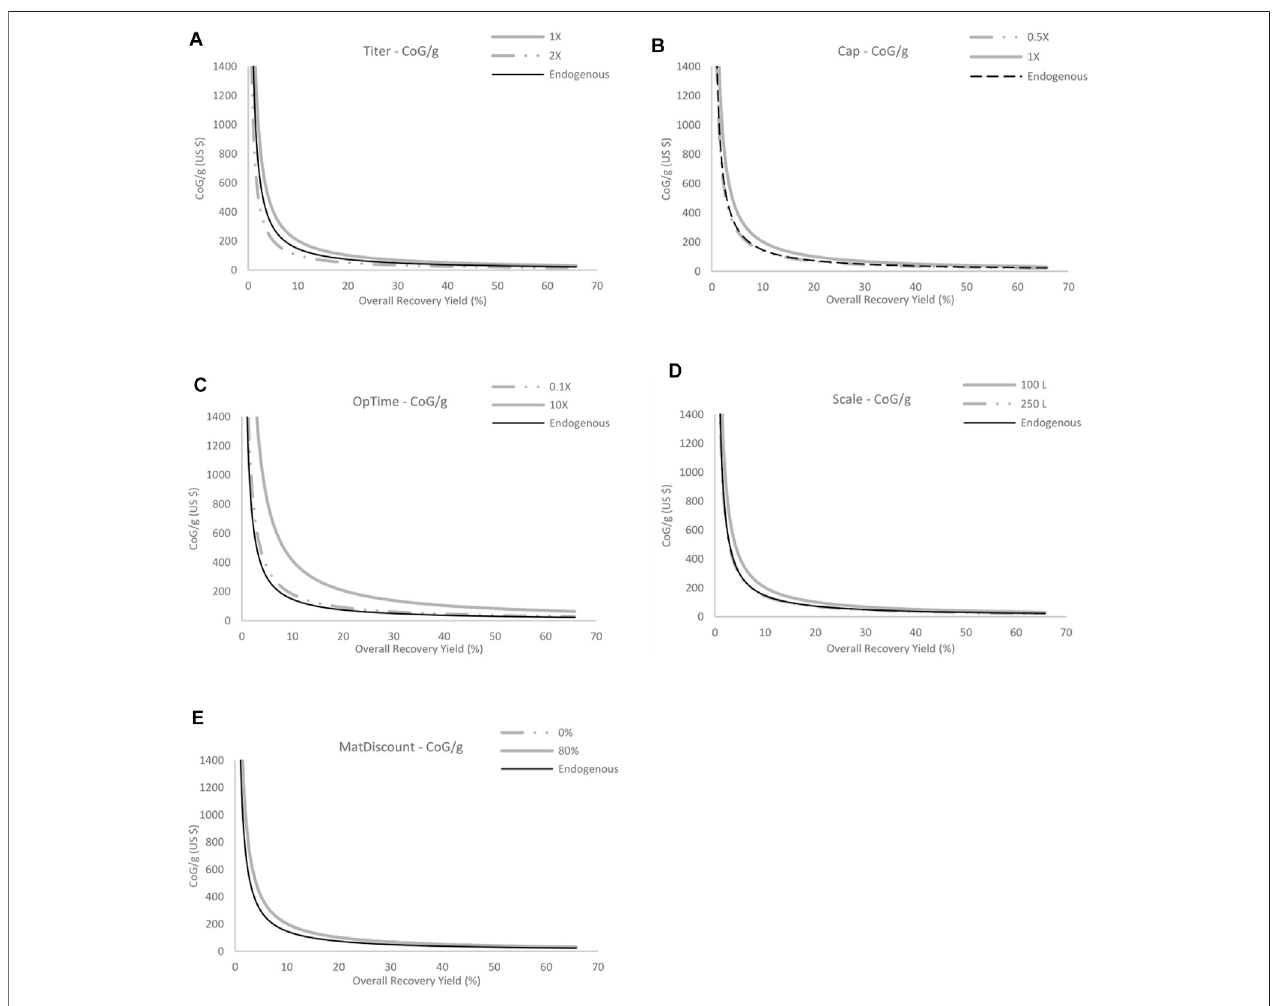
FIGURE 4 | Contrast of basal endogenous production (100 L, 0% material discount, 1X multipler for the rest of the variables) and recombinant production at each individual variable analyzed here – Production titer (A) , capital costs (B) , overall operation time (C) , bioreactor scale (D) , and materials costs discount (E). Data shown includes only the scenarios that fl ank endogenous CoG/g. For the variables operation time and materials discount as they are never below endogenous CoG/g, the maximum and minimum CoG/g are presented. For bioreactor scale (D) the endogenous and 250 L results are close to each other and difference is almost negligible. For materials discount (E) , the 0 and 80% difference is almost negligible and appear almost overlapped.